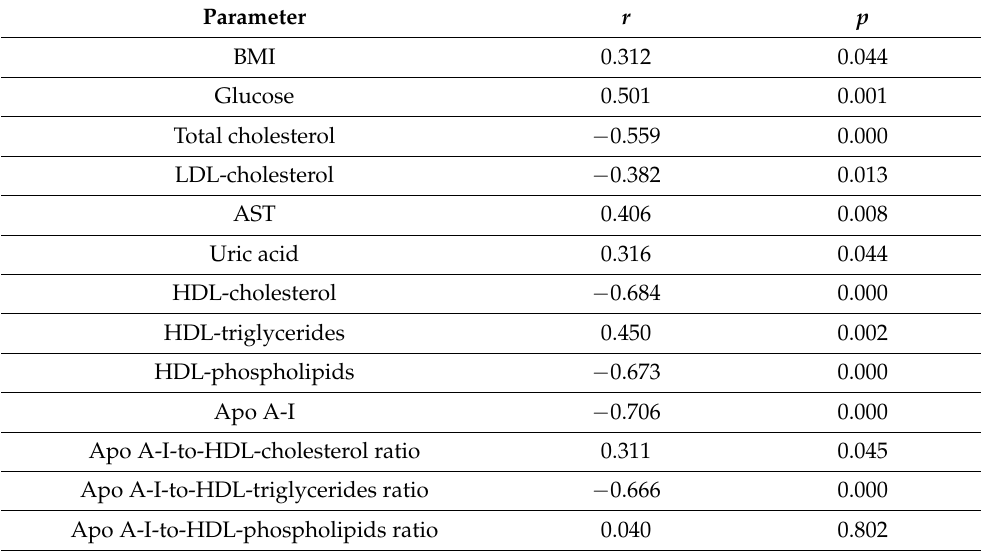
Table 2. Correlation analysis between the percentage of HDL denaturation at 8 h of incubation with urea 8 M and biochemical parameters.